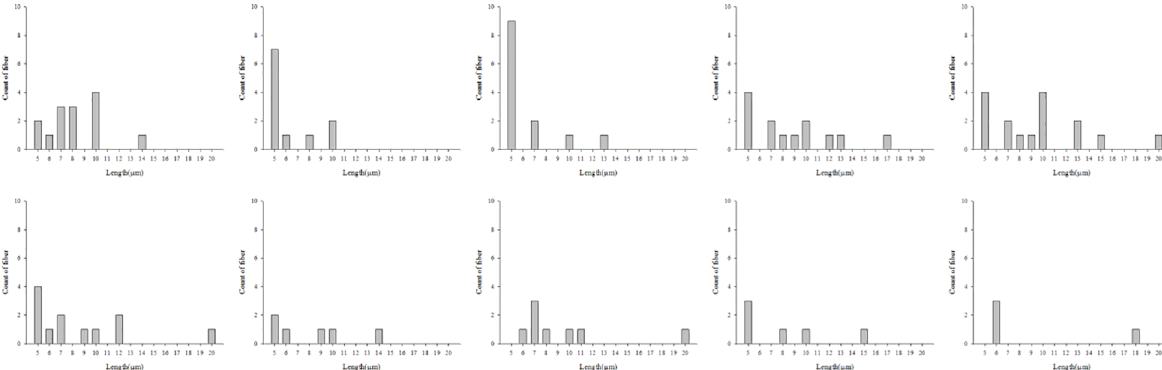
Fig 9. Length distribution according to applied voltage(amphibole type; 100–1,000V).